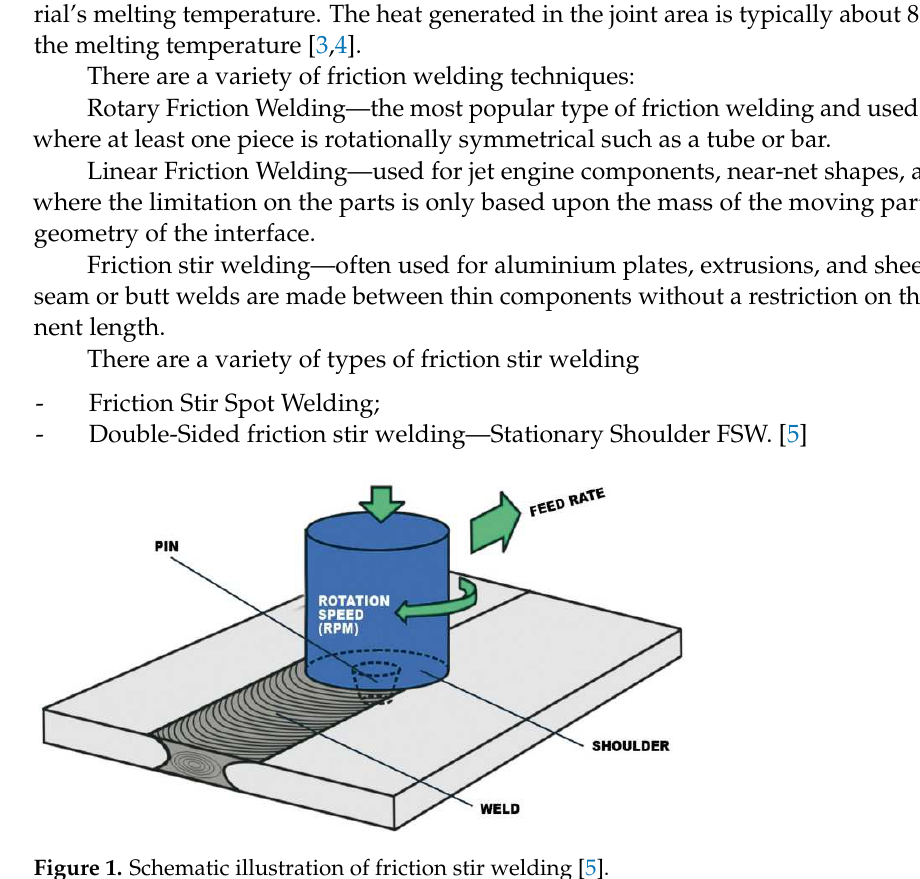
Figure 1. Schematic illustration of friction stir welding [5] .